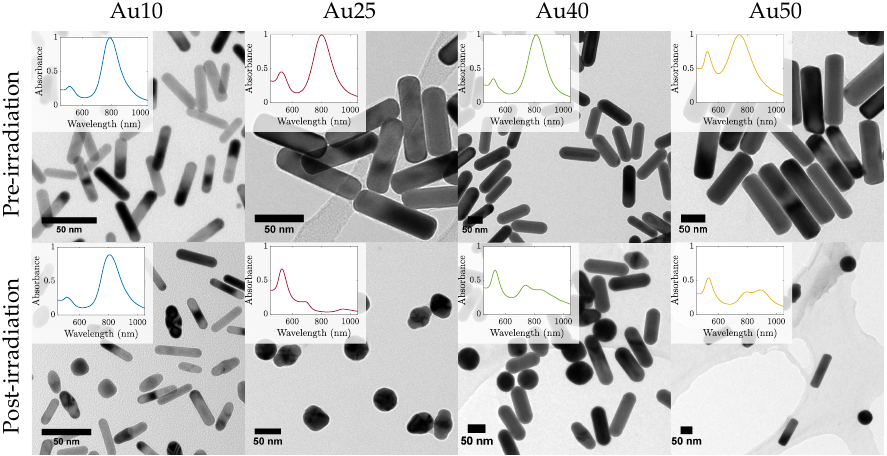
Figure 6. TEM images of all four sizes of AuNRs before (top row) and after (bottom row) pulsed laser exposure with a laser fluence = 19 ± 2mJ/cm 2 . Inset shows the corresponding measured absorbance